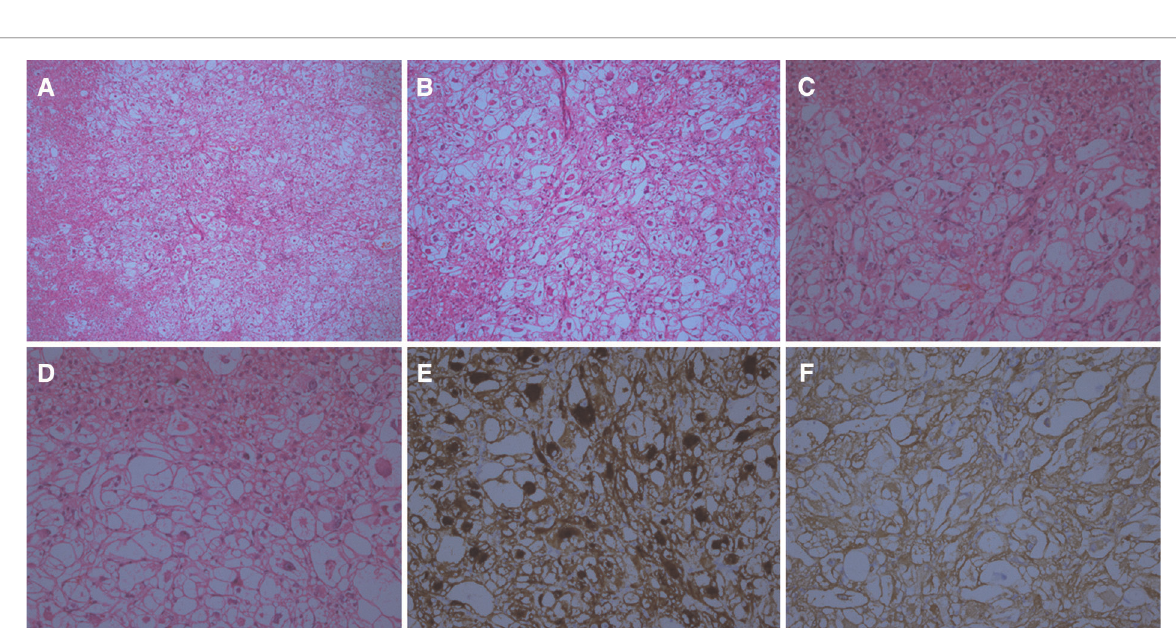
FIGURE 3 Histological fi ndings of this case ( A – D ) hematoxylin and eosin staining of the tumor under multiple magni fi cations ( A , ×50) ( B , ×100). ( C , ×200) ( D , ×400). Microscopically, the tumor boundary is unclear and grows into the surrounding liver tissue. Epithelioid-like tumor cells can be seen arranged in a nest-like shape. Vascular components are visible, but adipocytes and smooth muscle components are not found. Under a high microscope objective, the tumor nuclei are round or oval with obvious nucleoli and atypia. ( E ) Tumor cells stained positive for HMB 45. Magni fi cation at ×200. ( F ) Tumor cells stained positive for SMA. Magni fi cation at